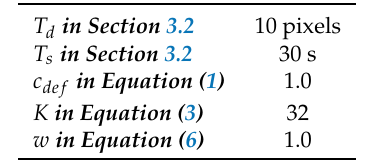
Table 3. Details of parameters in product change detection.